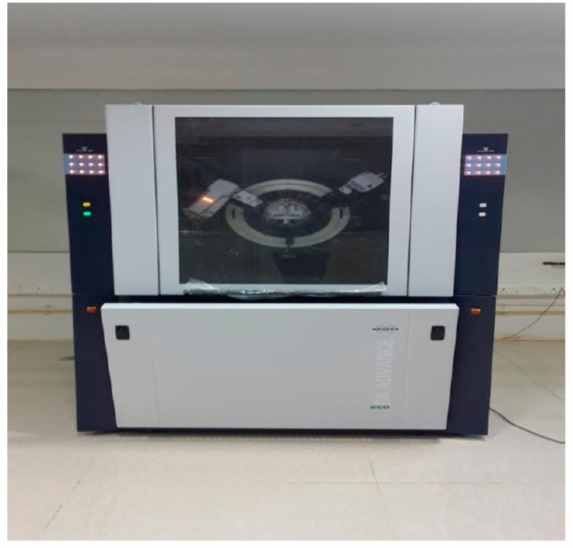
Figure 13. X-Ray